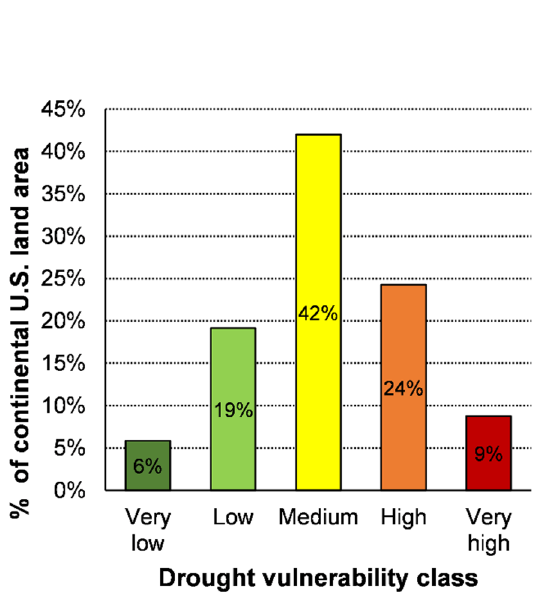
Figure 8. Areal portion of the contiguous U.S. found in each vulnerability category.